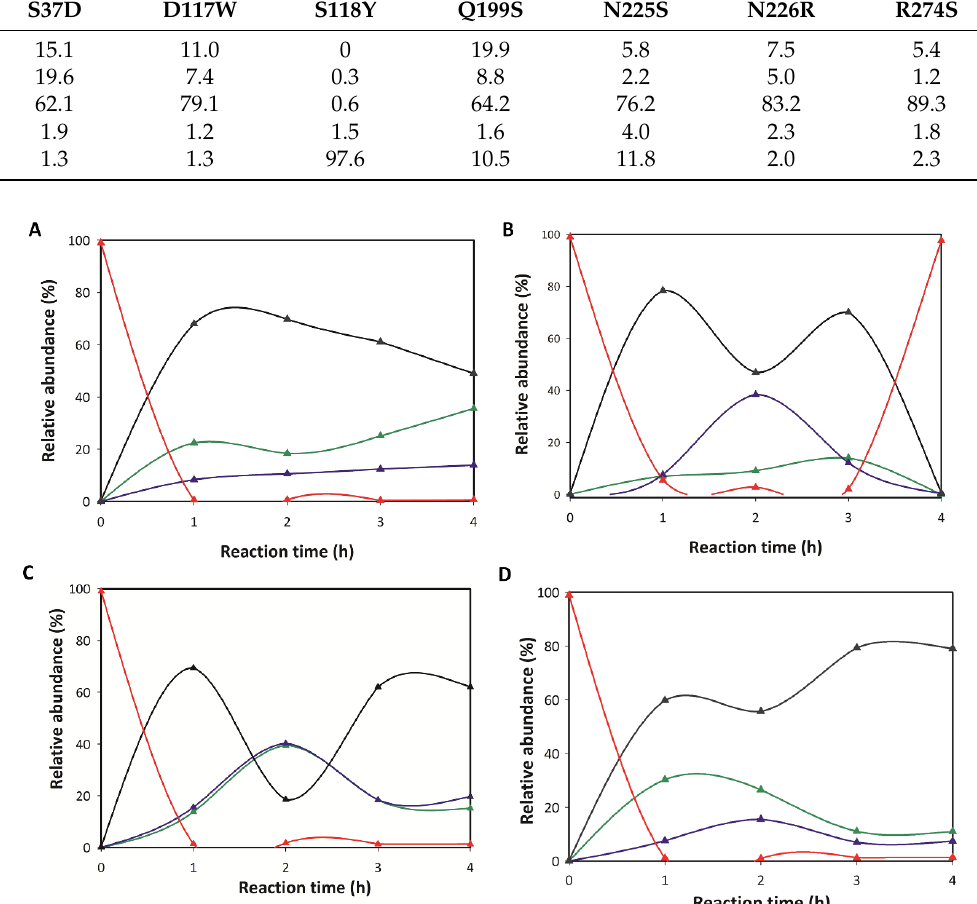
Figure 5. Time courses of NAG6 degradation catalyzed by wild-type Chit33 ( A ), S118Y ( B ), S37D ( C ) and D117W ( D ) variants. Relative abundance of the indicated NAG oligomer refers to total NAG derivatives detected by MALDI-MS in the reactions versus reaction time. Enzymatic reactions were conducted in 100 mM phosphate potassium, with a pH of 5.5 and 2.0 mM NAG6 at 45 °C. The color code is NAG2 ; NAG3 ; NAG4 ; NAG6 . The results are represented as the average of two independent assays.